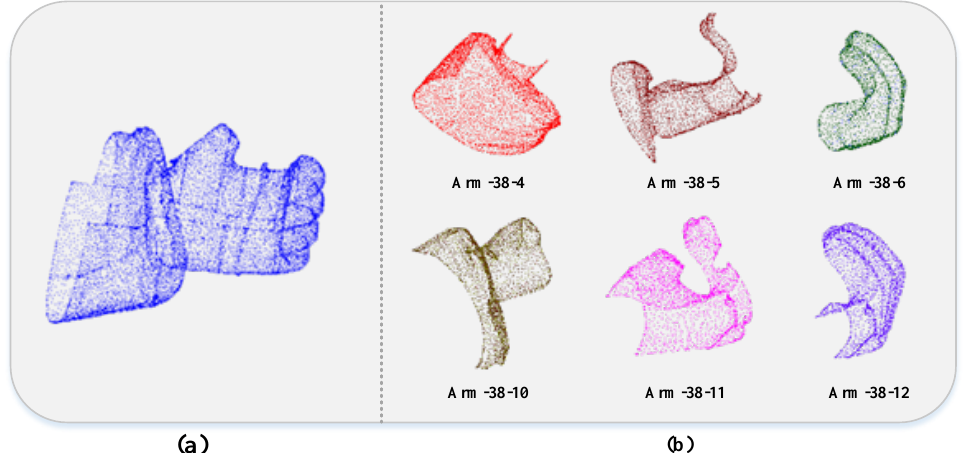
Figure 9. Point cloud patches of model 006192-Arm-38. ( a ) Raw point cloud model of 006192-Arm-38; ( b ) patch models of 2048 points.